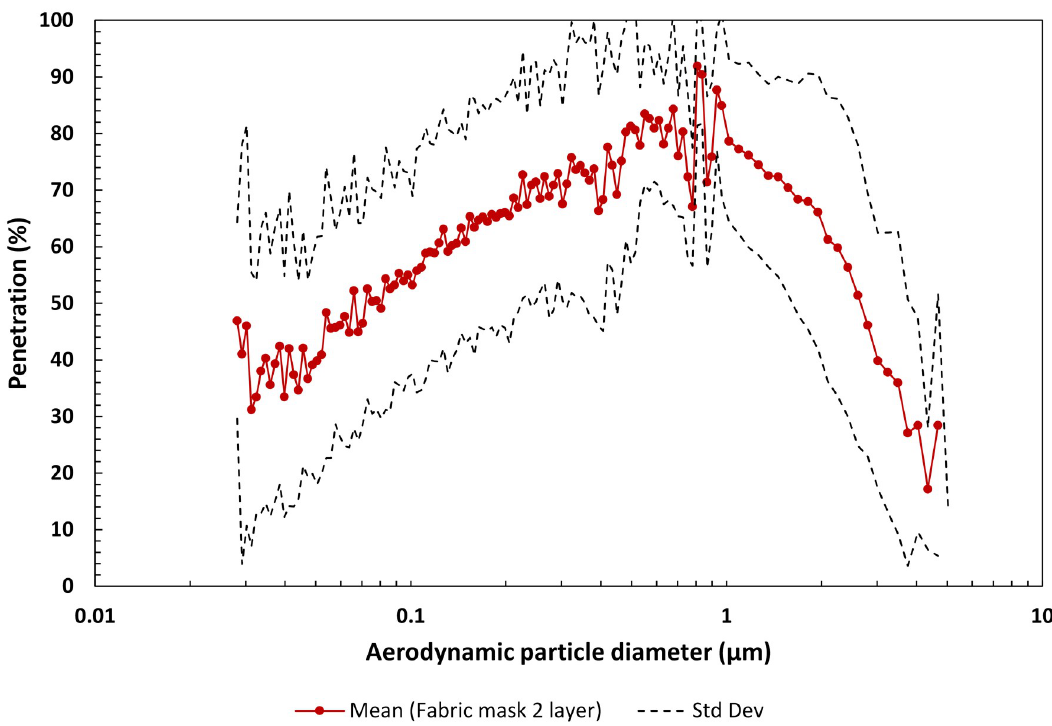
Fig 4. Mean penetration profile as a function of aerodynamic particle diameter for the material of five fabric masks comprised of 2 layers. Note, the penetration range is 0 to 100%. Materials included quilt batting, cotton, nylon, polyester and silk.